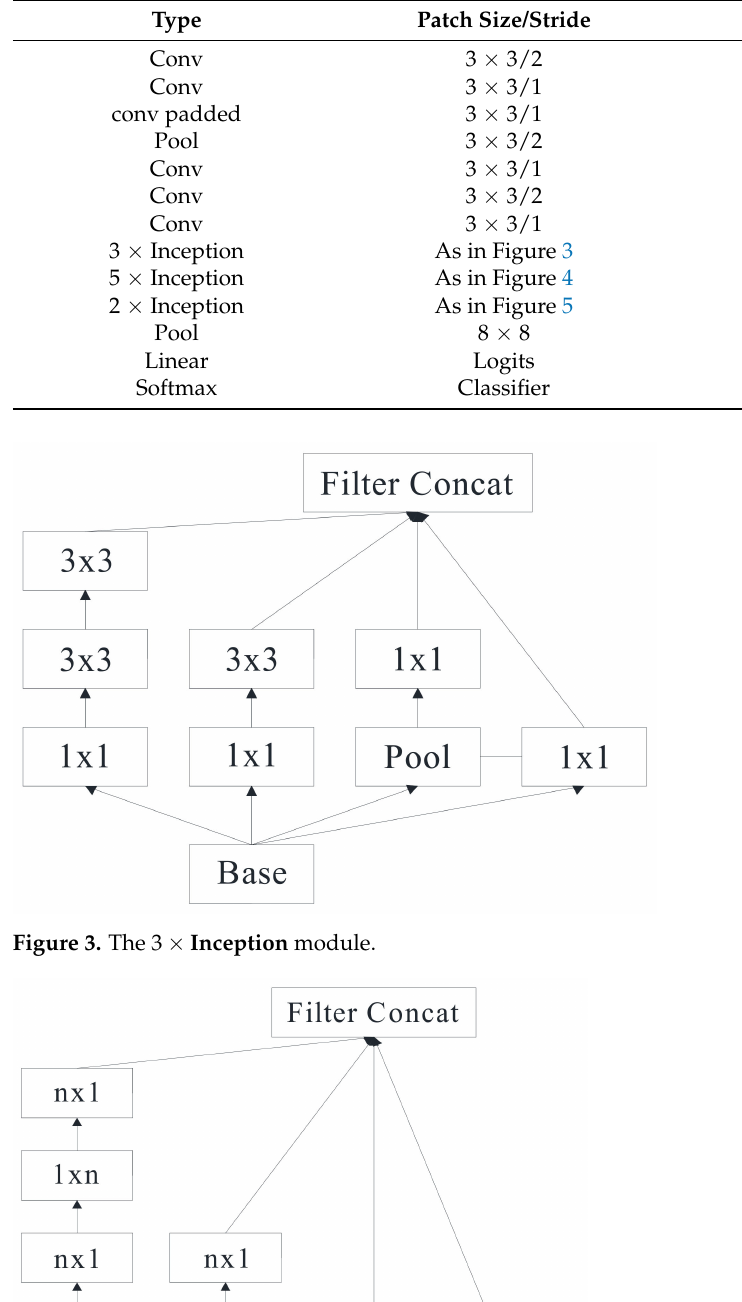
Table 1. Details of Inception_v2.